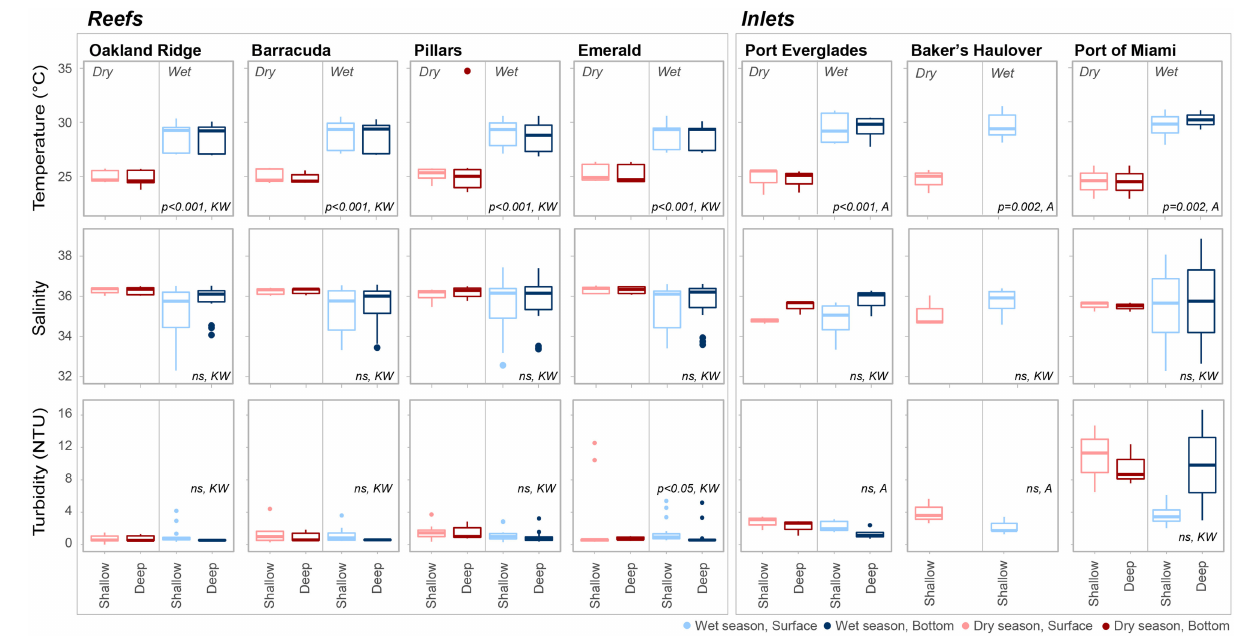
FIGURE 2 | Temperature ( ◦ C), salinity, and turbidity (NTU) at each of four reef and three inlet sampling sites. Data are divided into dry (red) and wet season (blue). Darker colors represent samples taken above the benthos while lighter colors represent samples taken at the surface. P values are given for significant differences as determined by ANOVA (A) or nonparametric Kruskal-Wallis (KW) tests. Non-significant ( p > 0.05) are marked ns.